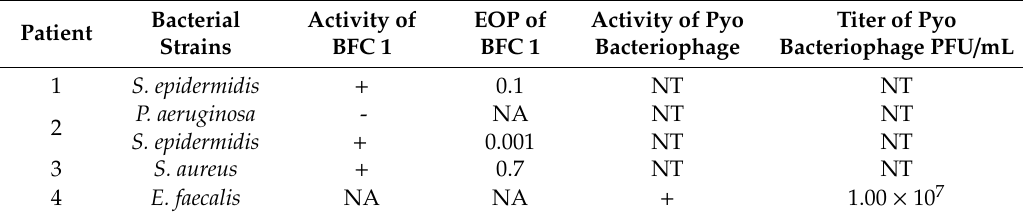
Table 3. Susceptibility testing of bacterial strains against phage cocktails. The bacterial strains from the first three patients were not tested against Pyo bacteriophage because this cocktail was not available in our center at the time. EOP, e ffi ciency of plating; PFU, plaque forming units; NT, not tested; NA, not applicable; + , active; -, inactive.